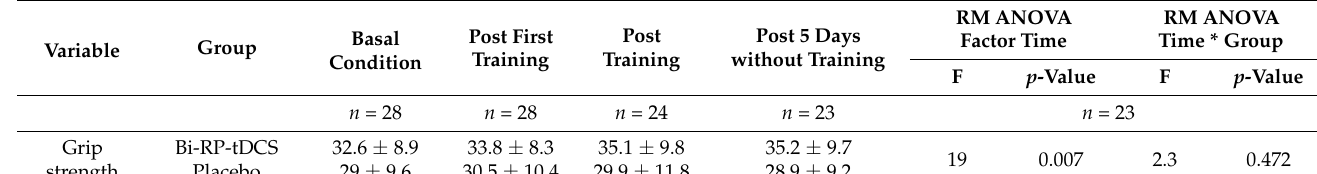
Table 3. Motor training and bi-RP-tDCS effects on grip strength (mean ± SD).